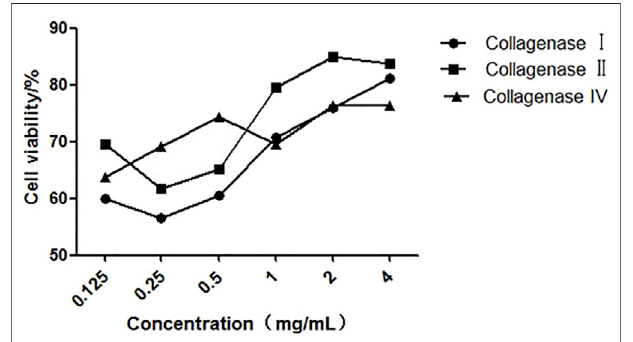
FIGURE3 | The effect of different concentrations ofcollagenases on cell viability during kidney tissue digestion.